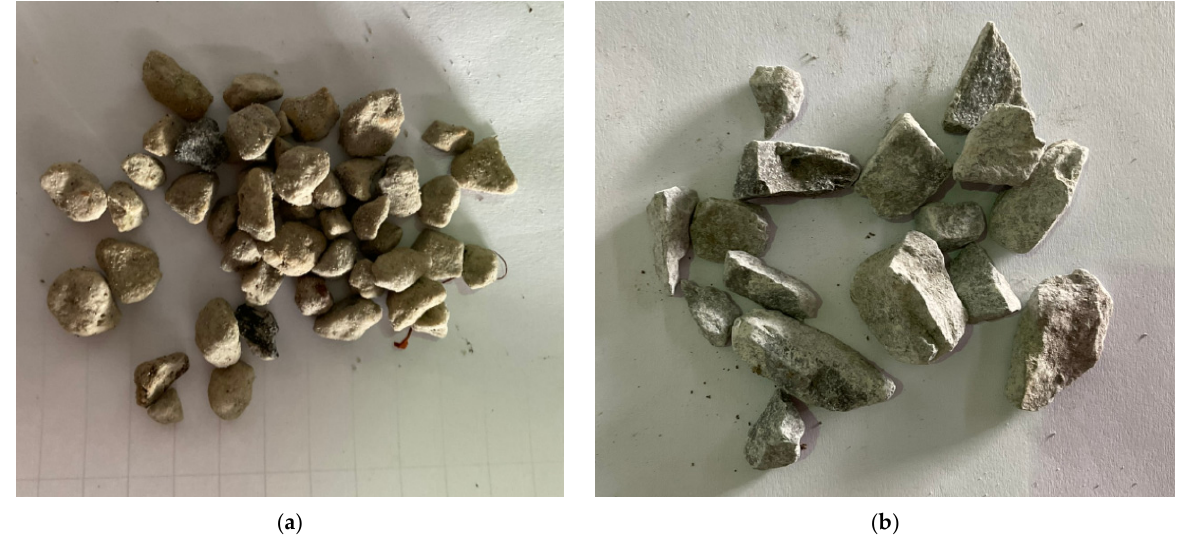
Figure 1. ( a ) Lightweight and ( b ) natural coarse aggregates.